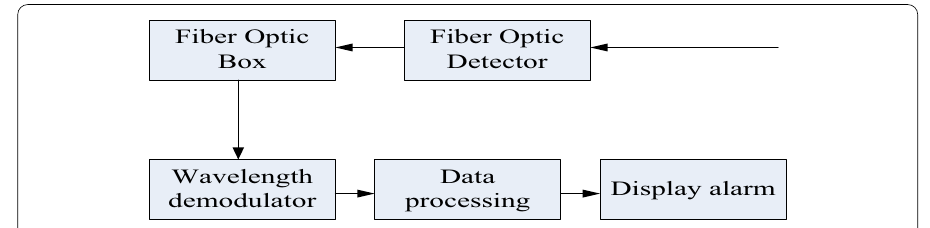
Fig. 2 Schematic diagram of temperature measurement system